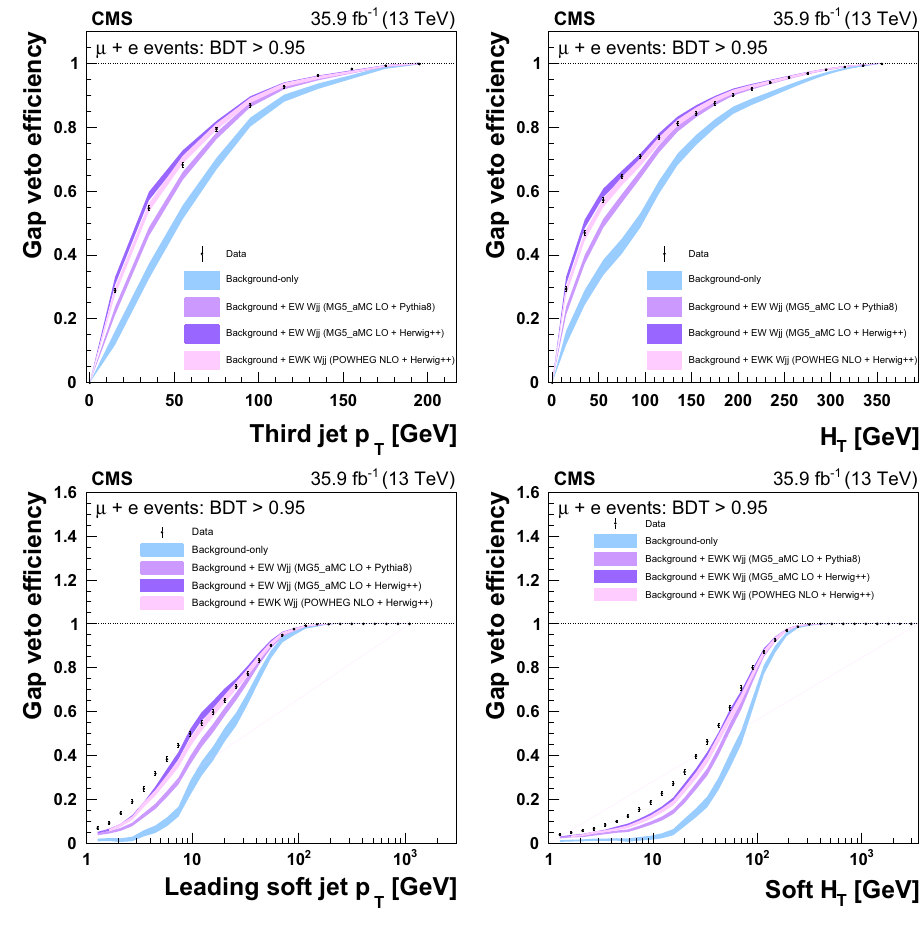
Fig. 19 Hadronic activity veto efficiencies in the signal-enriched BDT > 0 . 95 region for the muon and electron channels combined, as a function of the leading additional jet p T (upper left), additional jet H T (upper right), leading soft-activity jet p T (lower left), and soft-activity jet H T (lower right). The data are compared with the background-only prediction as well as background+signal with pythia parton showering and background+signal with herwig++ parton showering. In addition, the background+signal prediction from powheg plus herwig++ parton showering is included. The uncertainty bands include only the statistical uncertainty in the prediction from simulation, and the data points include only the statistical uncertainty in